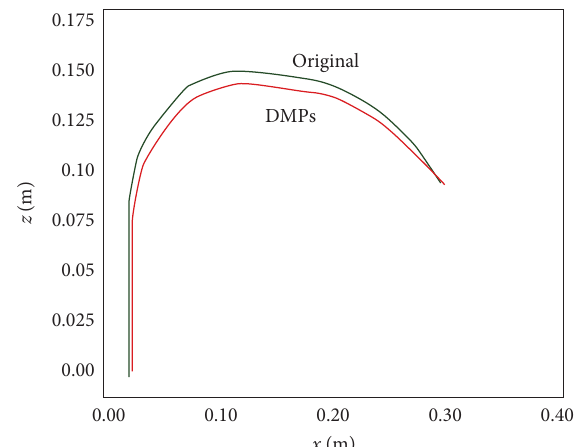
Figure 4: Curves of DMPs modulated according to the original target curve.